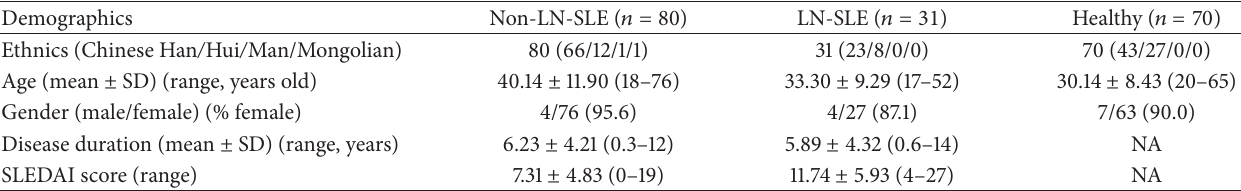
Table 1: Demographics of patients with systemic lupus erythematosus (SLE) without lupus nephritis (LN) (non-LN-SLE) ( 𝑁 = 80 ), SLE with LN (LN-SLE) ( 𝑁 = 31 ), and healthy control cohorts.